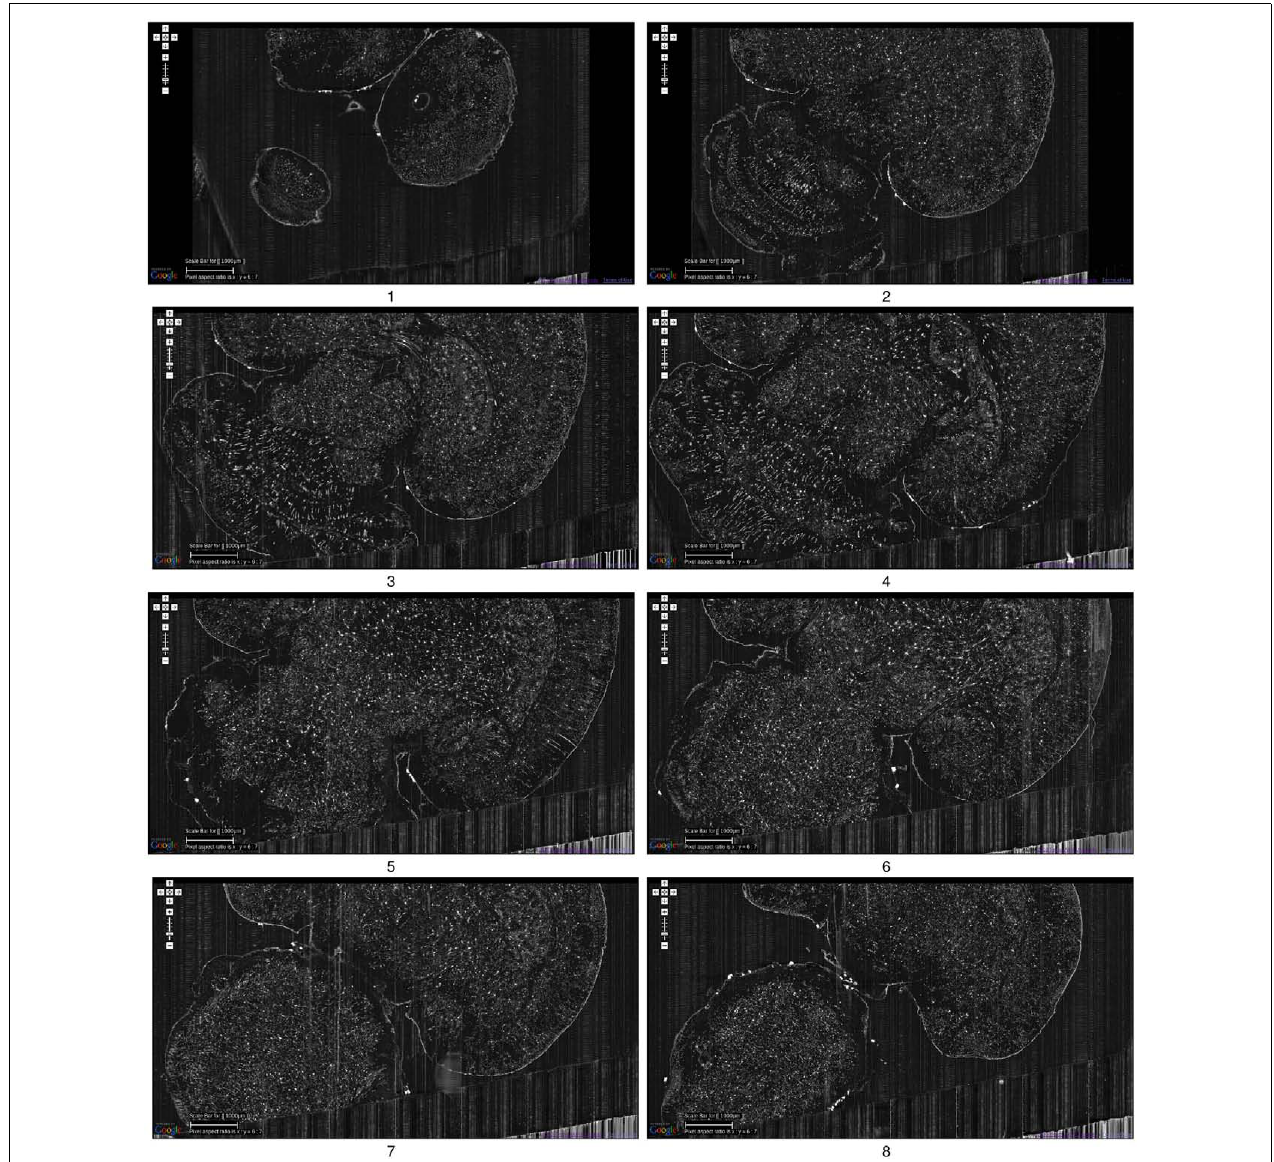
image is an overlay of 20 images in the z direction.The z-interval between each panel is 600 μ m.The numbers below the panels show the ordering. These are cropped screenshots from the KESMBA.This data set, obtained in 2008, is the first whole-brain-scale data set of the mouse at sub-micrometer